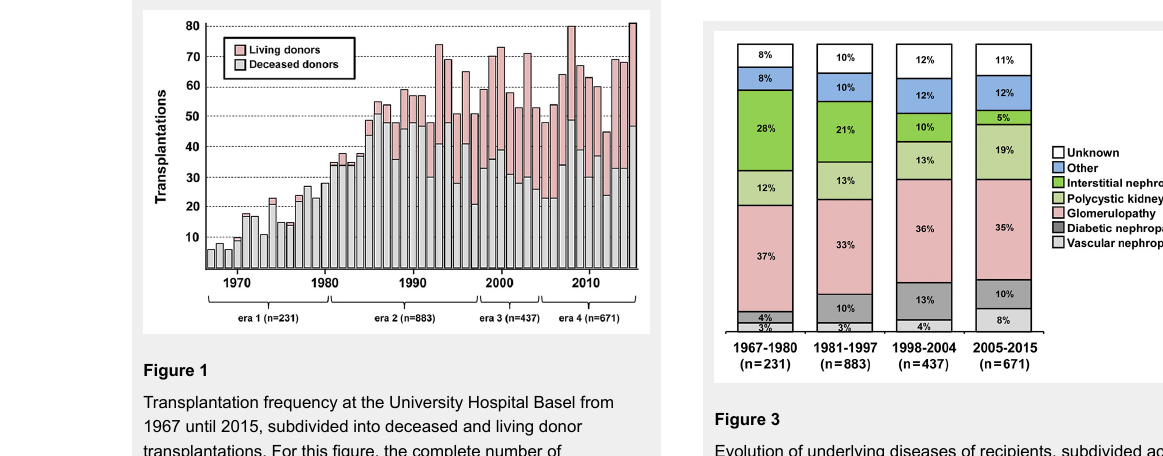
Evolution of underlying diseases of recipients, subdivided according to the predefined